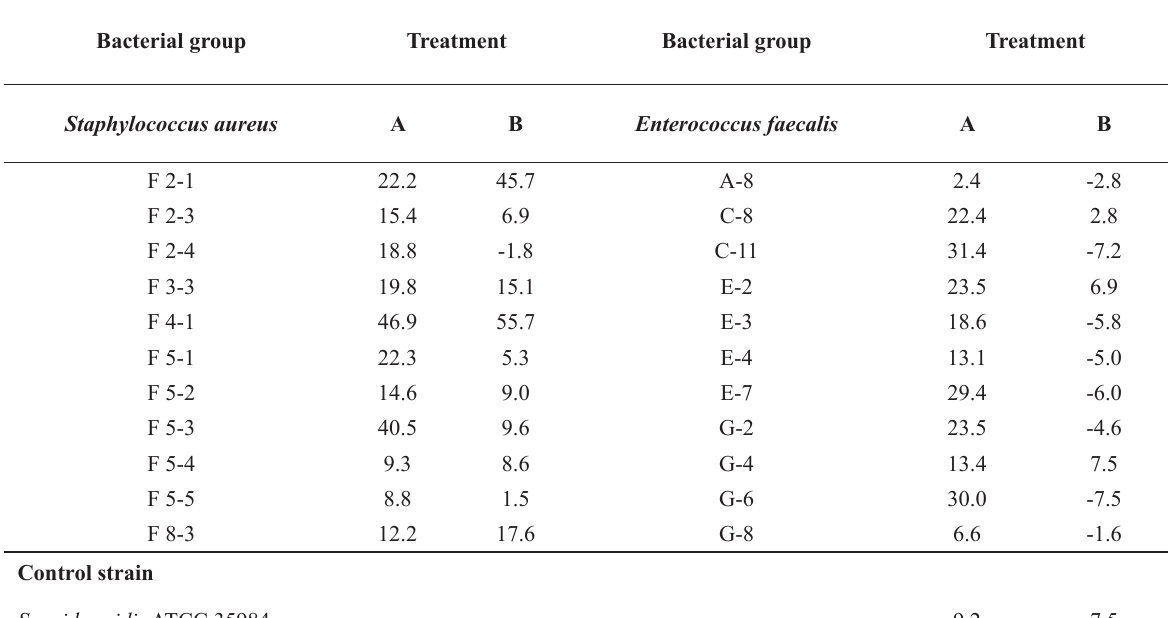
Percentage of antibiofilm potential of BLS P34 against Staphylococcus aureus and Enterococcus faecalis biofilms using the CV